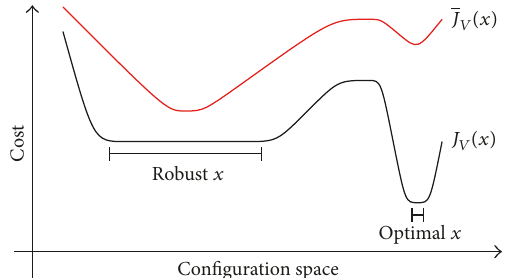
Figure 2: Exemplary of cost development regarding strategy 𝑥 . 𝐽 (𝑥) such that the corresponding solution 𝑥 ⋆ improves the 𝑉 performance measures; that is, 𝐽 𝑉 (̃𝑥 ⋆ ) > 𝐽 𝑉 (𝑥 ⋆ ) .